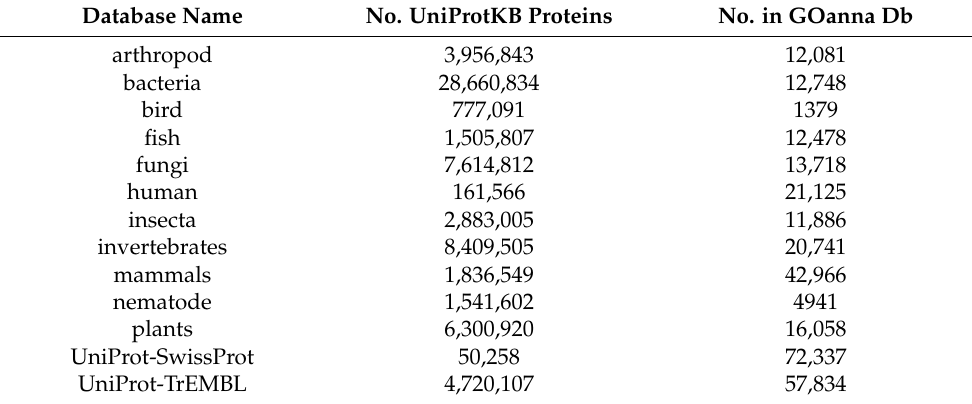
Table 1. GOanna version 2.2 databases. Databases are prepared from proteins that have GO annota- tions based upon taxonomic divisions. Protein numbers reported as of January 2019.